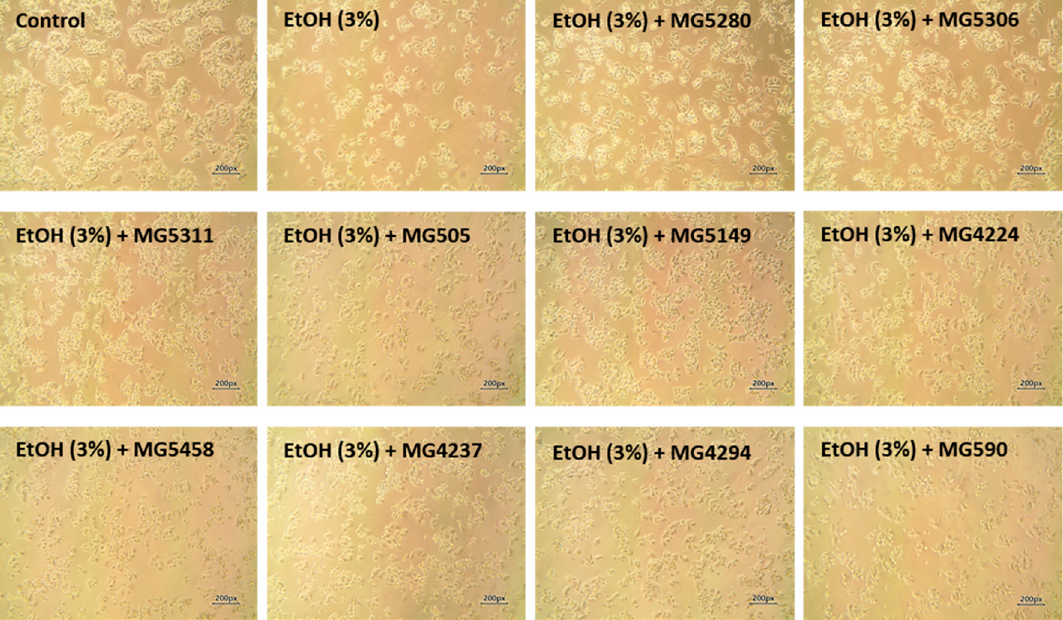
Figure 2. Microscopic morphological images of ethanol-induced HepG2 cells treated with or without CFEs (100 µg/mL) from LAB strains. The images were captured at 10 × magnification by phase-contrast light microscopy. EtOH, ethanol.